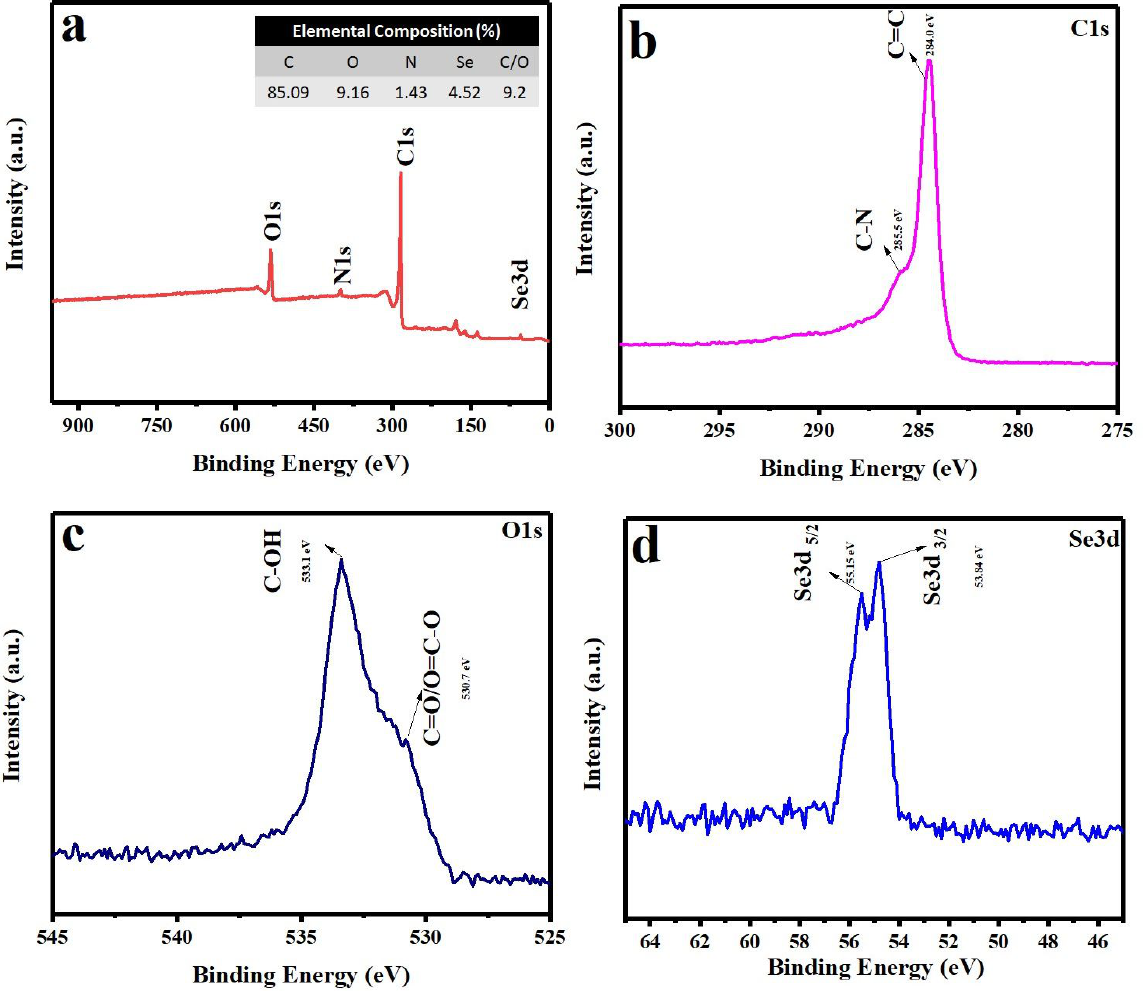
Figure 2: (a) XPS spectra survey and (inset) elemental composition of synthesized Se-nanorods/rGO nanocomposite, (b) C1s spectra, (c) O1s